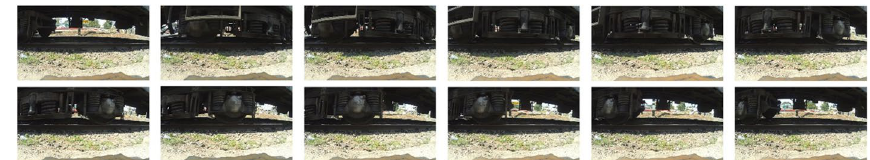
Fig. 1 Video frames of train rolling stock of a moving train at 30 kmph